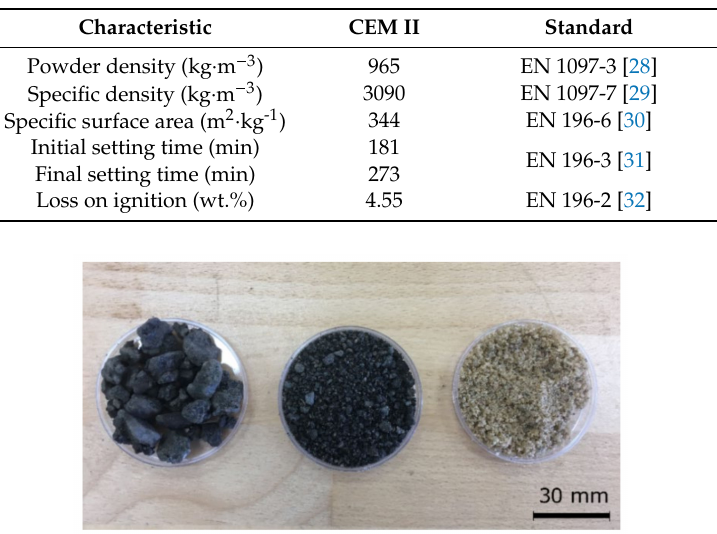
Table 2. Material properties of CEM II.